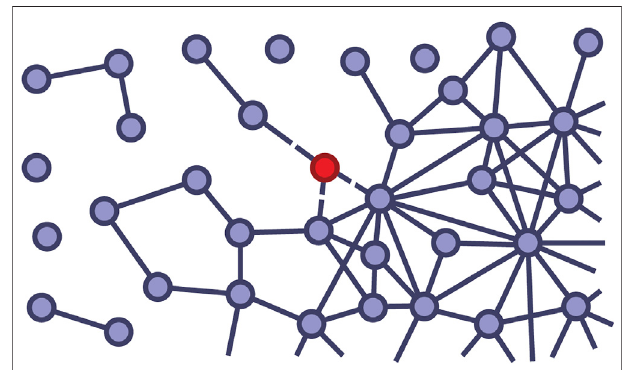
FIGURE2| Illustrationofthehypotheticalcuttingoflinksto fi ndaformula for the giant component size. We pick a random node (red), then cut all of its links. We can say that the probability that the randomly picked node is not in thegiantcomponentbeforethecuttingisthesameastheprobabilitythat none of the node ’ s former neighbors are part of the giant component after the cutting. This statement gives us a self-consistency condition from which the giant component size can be calculated. The cutting of links is essential, as it enables us to treat giant component members of the former neighbors as independent random